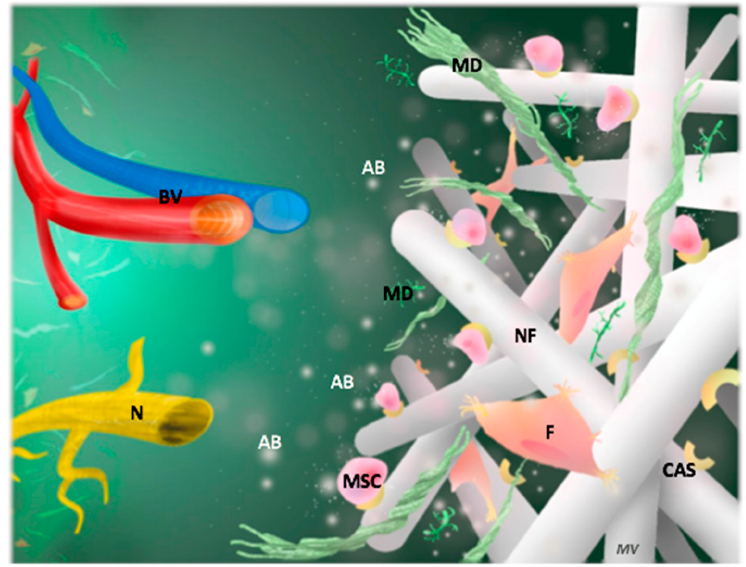
Figure 2. Polymer instructive sca ff old for endodontic regeneration. Incorporation of active biomolecules inside the sca ff old allows orchestration of tissue regeneration and attraction of resident cells according to ‘’cell homing process”. Stem cells cultured in the sca ff old optimize the pulp regeneration, notably matrix deposition. AB; Active biomolecules (white rounds), BV; Blood vessels, CAS; Cellular adhesion site, F; Fibroblasts, MD; Matrix deposition, MSC; Mesenchymal stem cells, N; Nerves, NF;